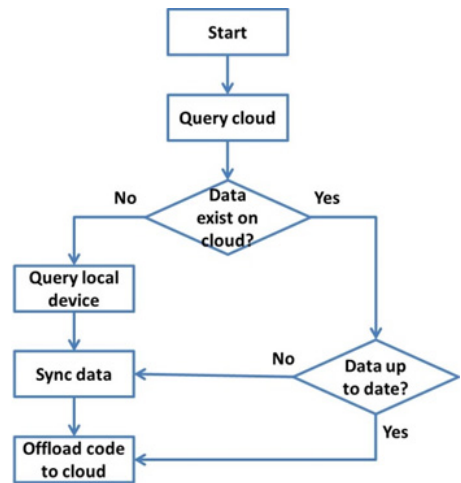
Figure 10: MDSS reduces the amount of data transferred in the network if the cloud already has the latest application data.